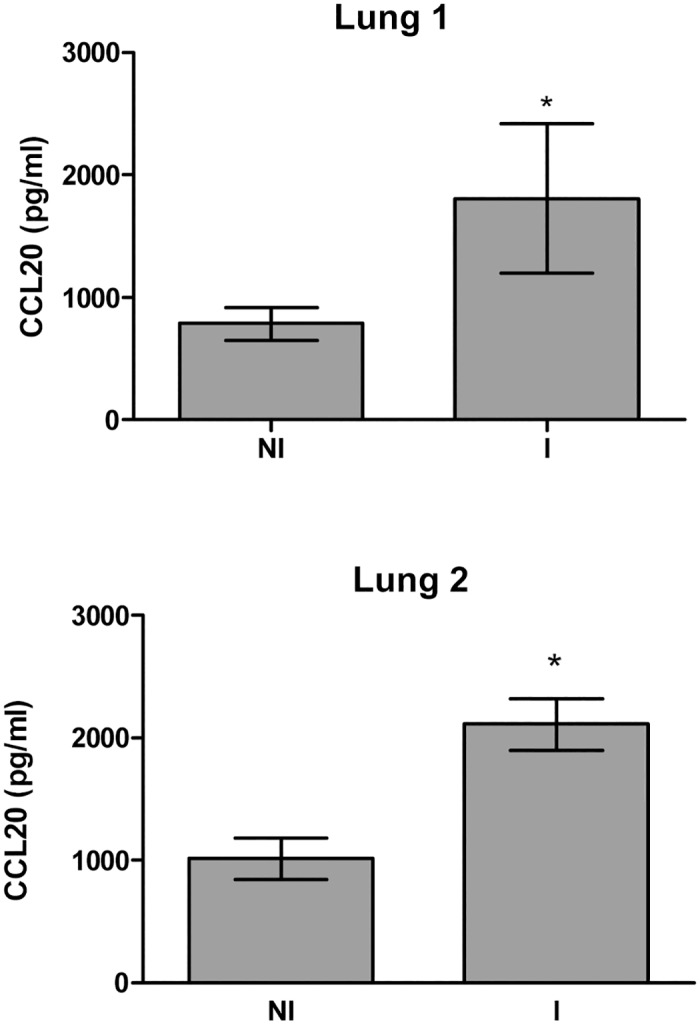

B. abortus induces CCL20 secretion in human lung tissue explants.Samples of healthy lung tissue (approximately 1 cm3) from two donors (Lung 1 and Lung 2, respectively) were incubated with a B. abortus 2308 suspension (107 CFU/ml) or medium for 24 h. CCL20 levels were determined by ELISA in culture supernatants from infected (I) and non-infected (NI) explants. Results are the mean ± SEM of triplicate determinations for each sample. *,P < 0.05 as compared with the non-infected explant from the same donor (Student t test).